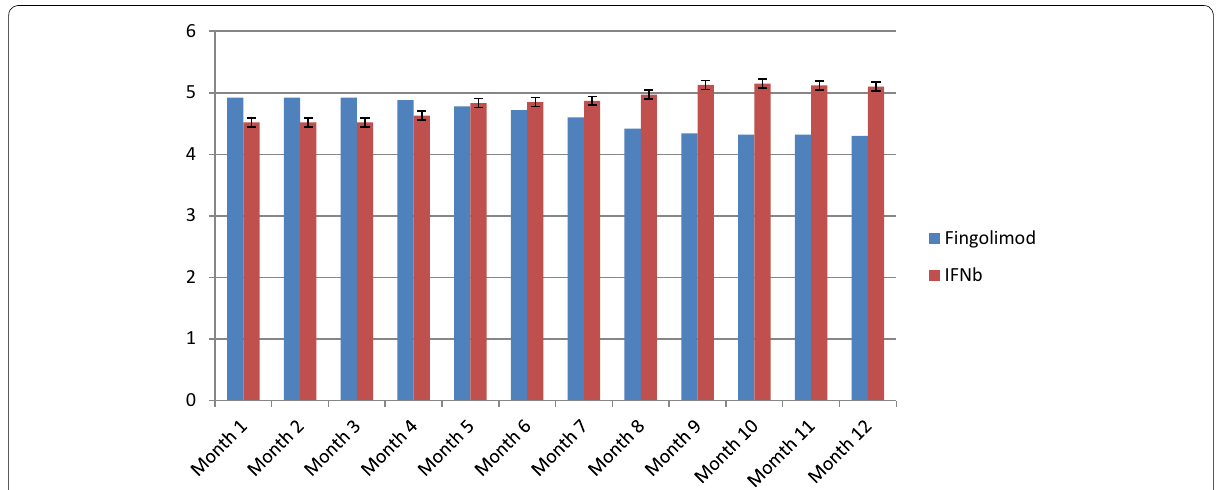
Fig. 1 The EDSS scores in each month during the study